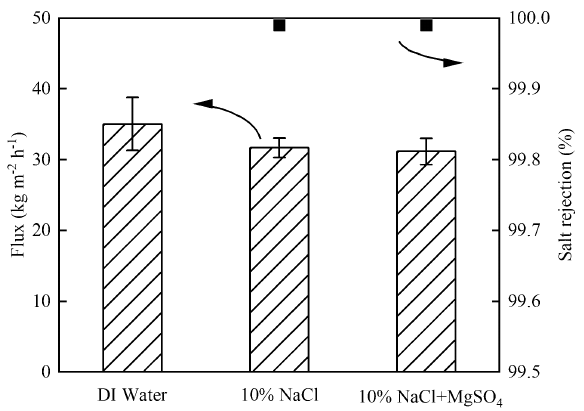
Fig. 4 PV performance of c-GO-PEI